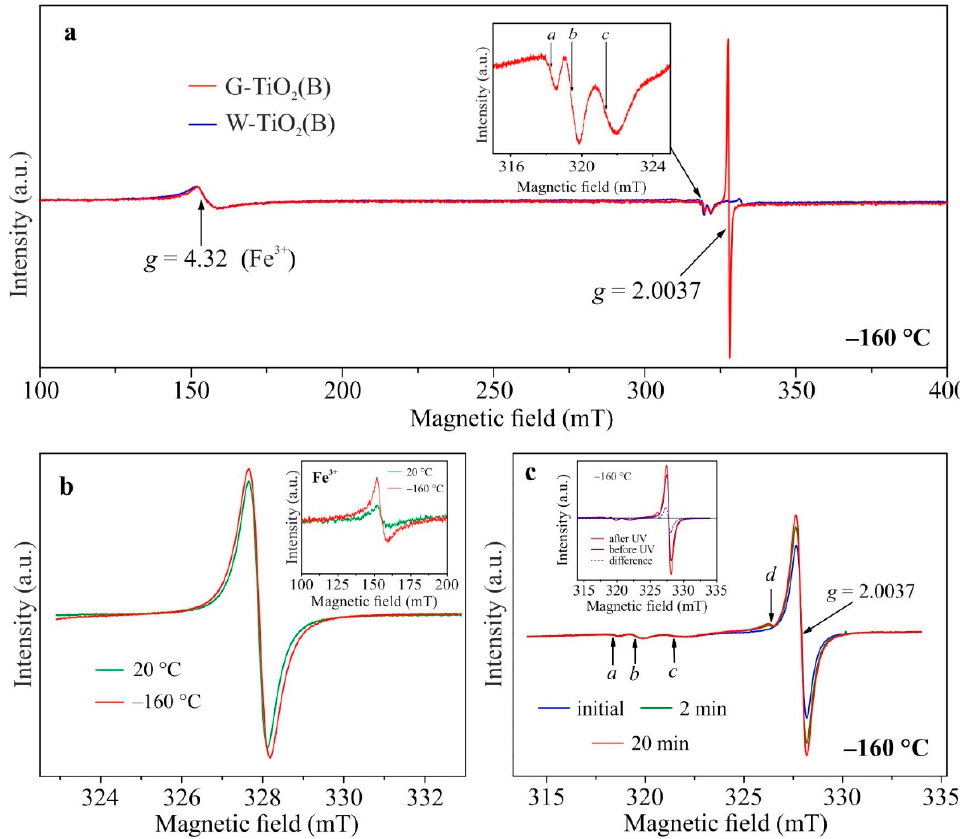
Figure 2. EPR spectra of W-TiO 2 (B) and G-TiO 2 (B) at –160 °C in the X-band (enlarged fragment with low-intensity components “ a ”, “ b ”, and “ c ” for G-TiO 2 (B) is shown in insert) ( a ), view of the main component of EPR spectrum for G-TiO 2 (B) at –160 °C and 20 °C (the inset shows a low-intensity component of the spectrum associated with Fe 3+ ions) ( b ), and evolution of the EPR spectrum for G-TiO 2 (B) upon the ultraviolet irradiation (the inset shows a difference between EPR spectra before and after 20 min of irradiation) ( c ).